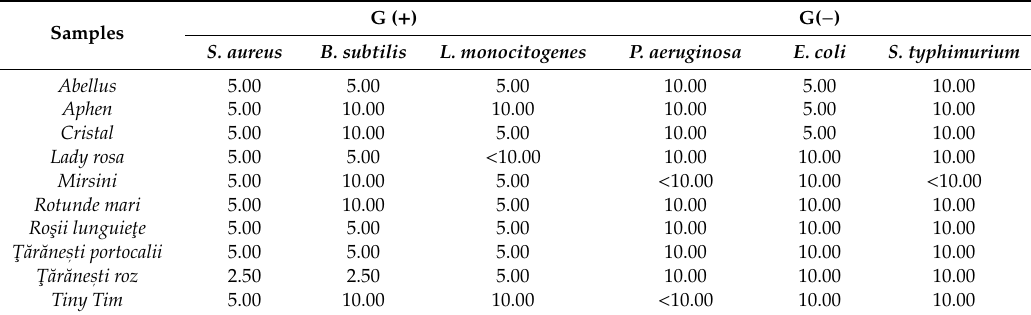
Table 3. Minimum inhibitory concentration (mg tomato peels / mL) of the methanolic extracts.